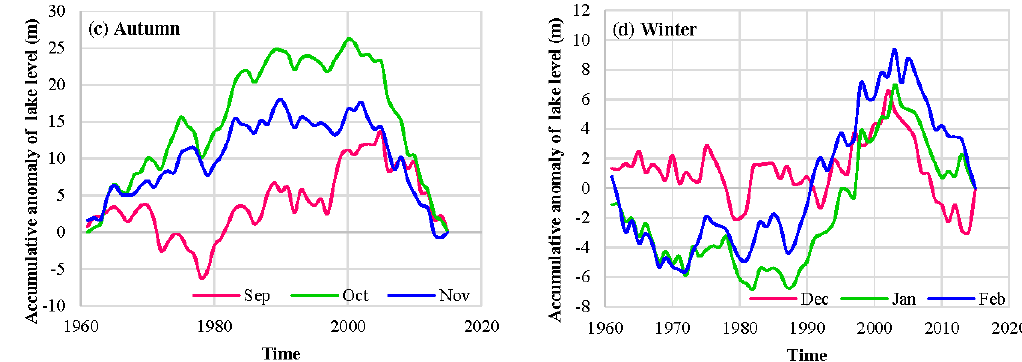
Figure 4. Accumulative anomaly curves of seasonal lake levels during 1961–2015. ( a ) Spring; ( b ) Summer; ( c ) Autumn; ( d ) Winter.